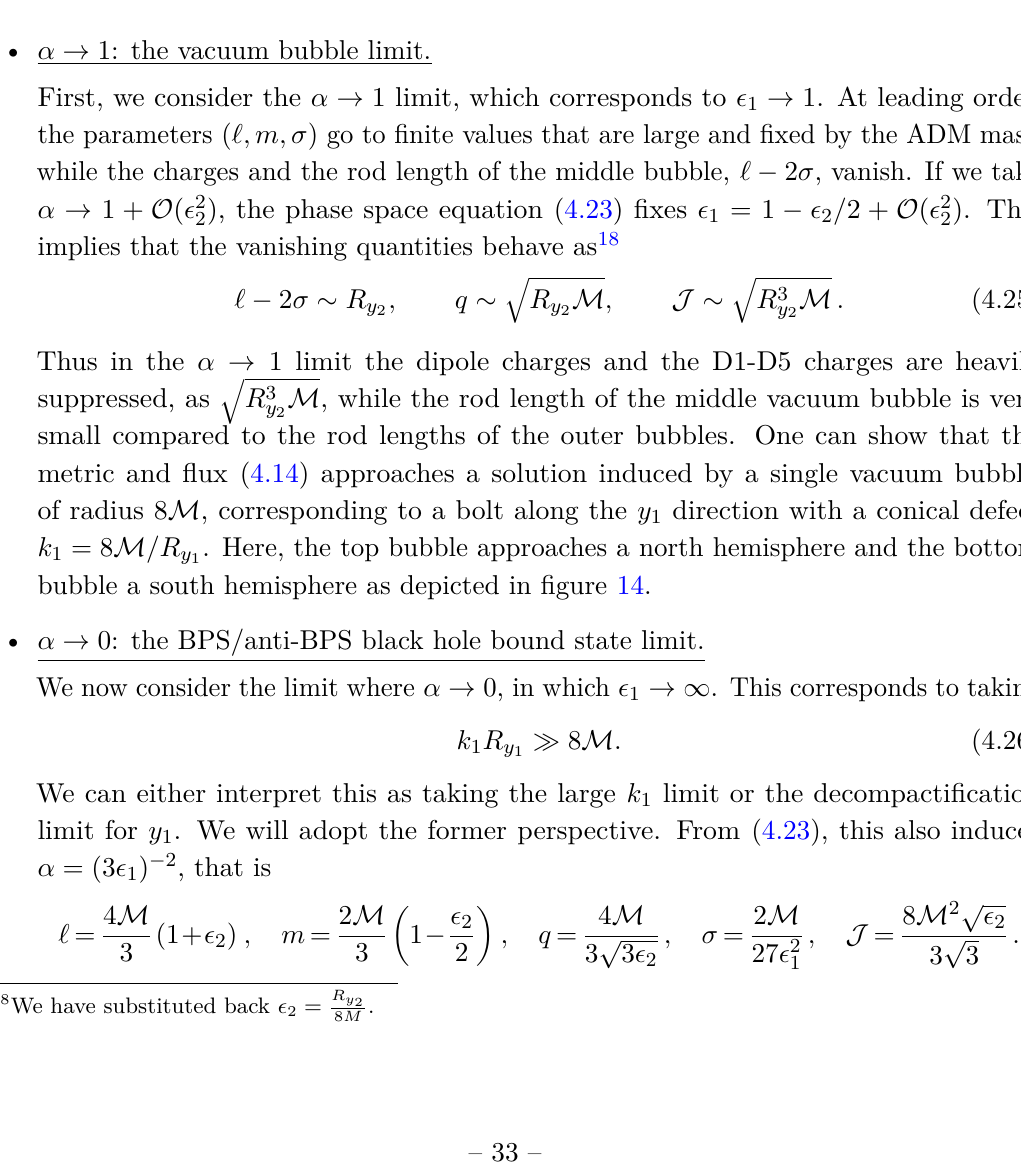
Figure 14 . Schematic description of the bubbles in the phase space. When α → 1 , the solutions approach a vacuum bubble. When α → 0 , the solutions scale towards the BPS/anti-BPS D1-D5 black hole bound states of section